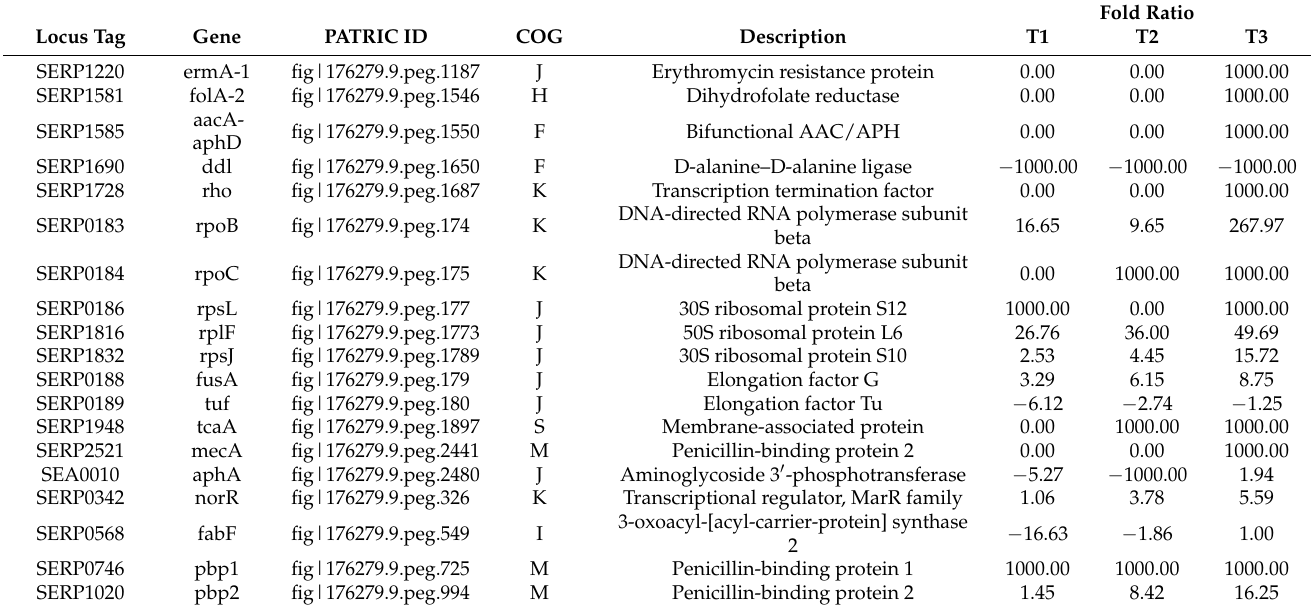
Table 2. Differentially expressed proteins associated with antibiotic resistance.